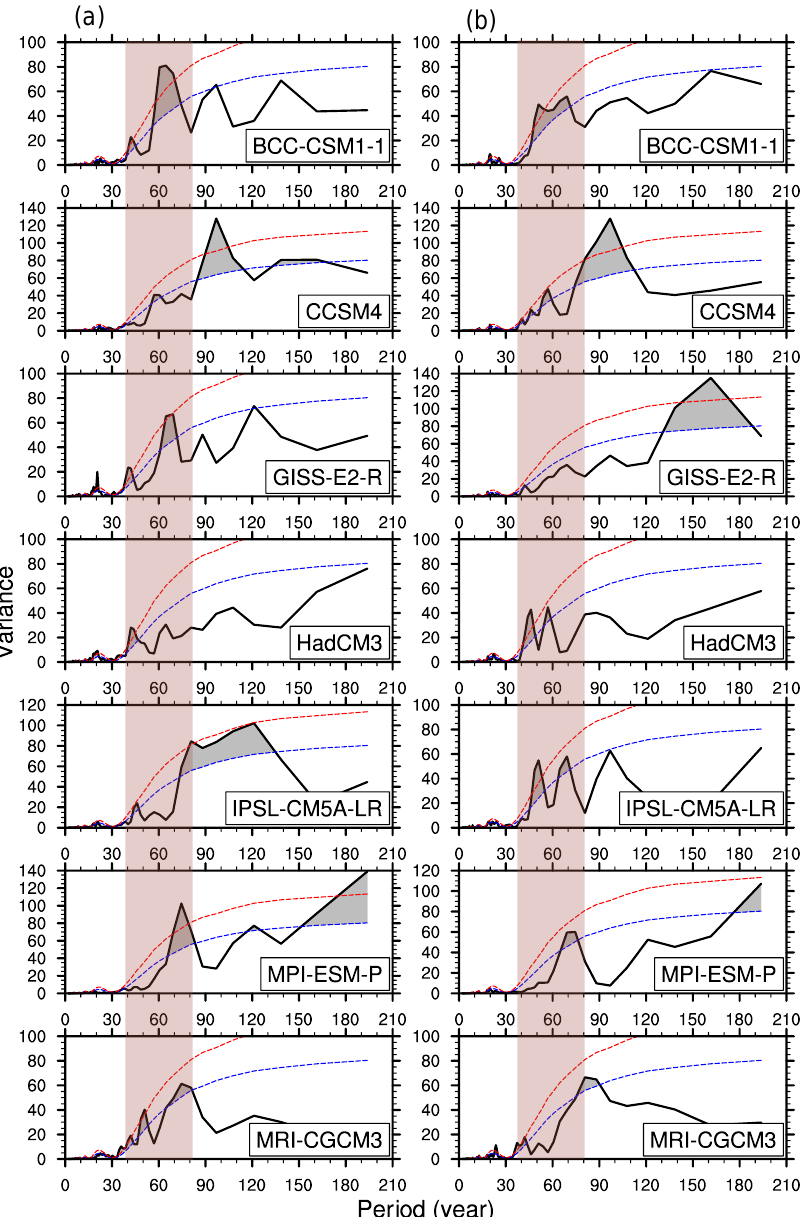
Figure 7. Power spectrum of 31-year RPCs (a) and RCs (b) in the PMIP3 models. Red (blue) dashed lines represent the 95% (90%) signif- icance level estimated from 10000 Monte Carlo simulations. Spectra passing the 90% significance test are shaded in gray. The periodicity from the 40- to 80-year period is marked with the brown vertical